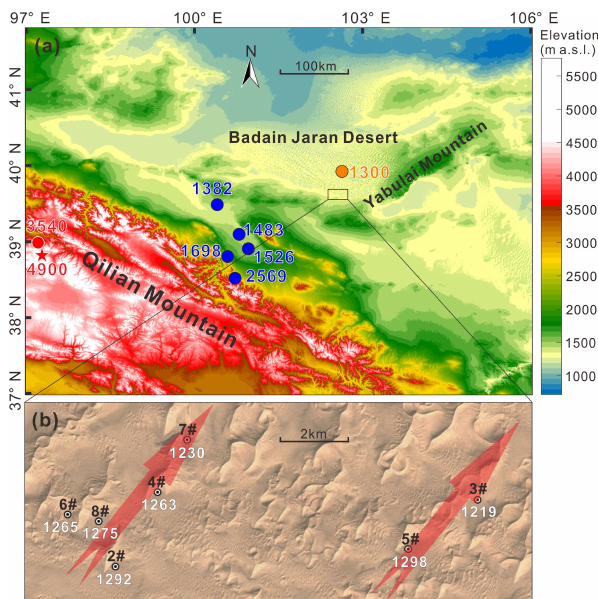
Figure 3. Elevation map of the Qilian Mountains and BJD areas (a) and groundwater wells drilled in the BJD (b) . Locations for pre- cipitation sampling in different areas are also shown in (a) , as well as the elevation (ma.s.l.). The elevations of static groundwater lev- els in seven of the extraction wells (well no. 1 is far away from these wells and hence not shown) are indicated by white text in (b) . Ar- rows in (b) show the estimated groundwater flow direction (based on groundwater